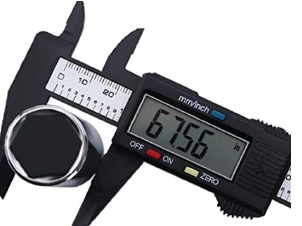
Figure 1. Measurement with a digital caliper [34].